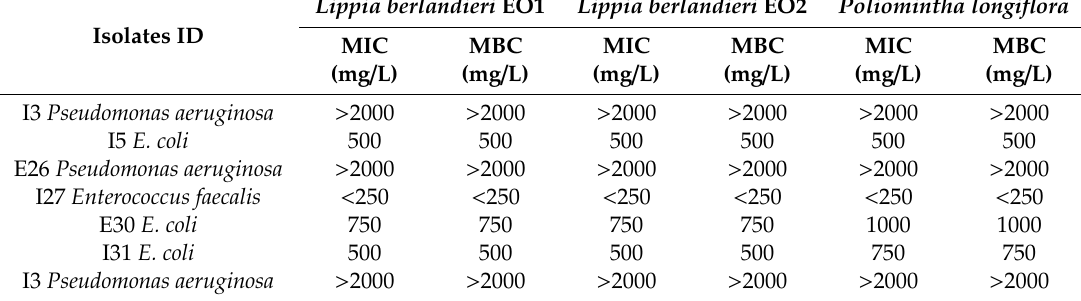
Table 2. Minimal inhibitory concentration and minimal bactericidal concentration of three di ff erent Mexican oregano essential oils against biofilm-forming multidrug-resistant bacterial isolates from UTI urine